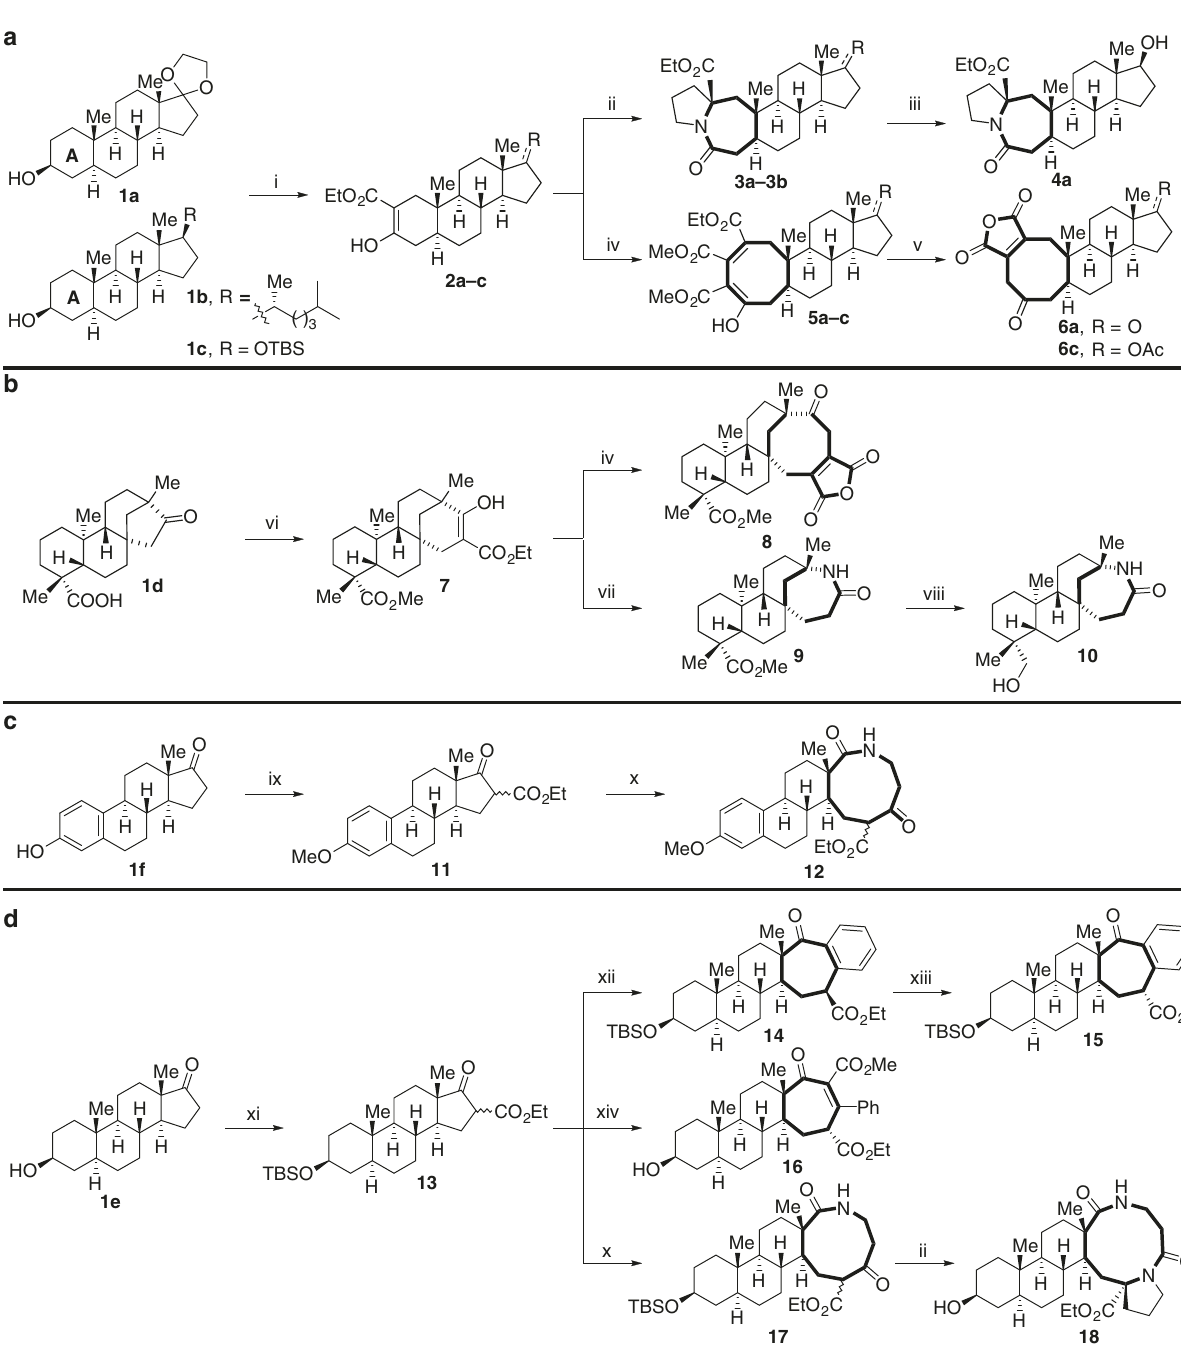
Fig. 2 Ring expansion of polycyclic natural products based on native C – O bonds. a A-ring expansion of dehydroepiandrosterone and cholesterol. b D-ring expansion of isosteviol. c D-ring expansion of estrone. d D-ring expansion of dehydroepiandrosterone. (i) (a) TPAP, NMO, 4 Å MS, CH 2 Cl 2 , (b) LDA, THF, then CNCO 2 Et, − 78 °C; (ii) (a) NaH, HMPA, THF, rt, then 1-Chloro-3-iodopropane, rt, (b) NaN 3 , DMF, 80 °C, (c) CF 3 COOH, rt; (iii) NaBH 4 , MeOH, − 78 °C; (iv) NaH, toluene, then DMAD, rt; (v) HCl, AcOH, 120 °C; (vi) (a) Me (cid:129) Et 2 SO 4 , LiOH, THF, 65 °C, (b) Ethyl diazoacetate, BF 3 2 O, Et 2 O/CH 2 Cl 2 ,